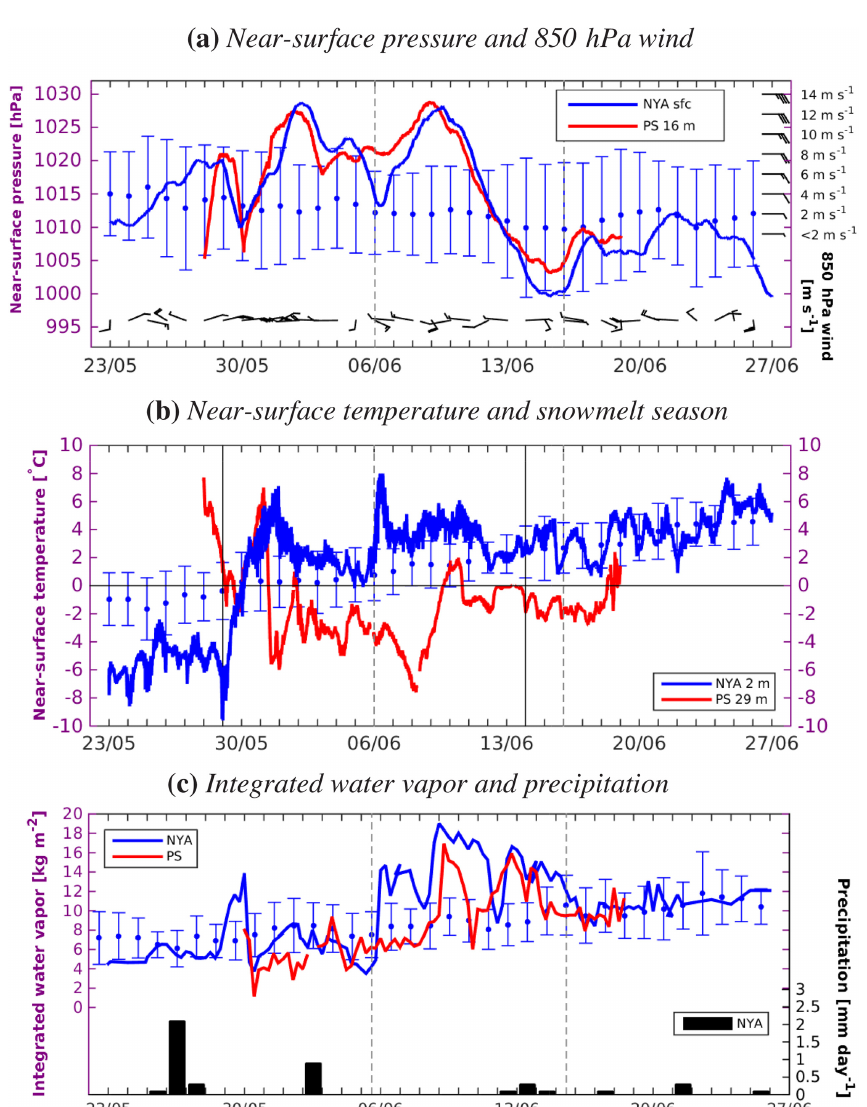
Figure 2. (a) Near-surface pressure (graphs) and 850hPa horizontal wind (bars for speed, vectors for direction), (b) near-surface air temper- ature (graphs) and snowmelt season (solid vertical lines), and (c) vertically integrated water vapor (graphs) and precipitation (bars) measured at Ny-Ålesund (NYA; blue and black) and Polarstern (PS; red) over the ACLOUD/PASCAL measurement period (23 May–26 June 2017). Dots and intervals indicate daily average and standard deviation, respectively, over the Ny-Ålesund long-term period (1993–2016). Dashed vertical lines distinguish the Polarstern ocean-crossing periods from the ice-attached period (6–16